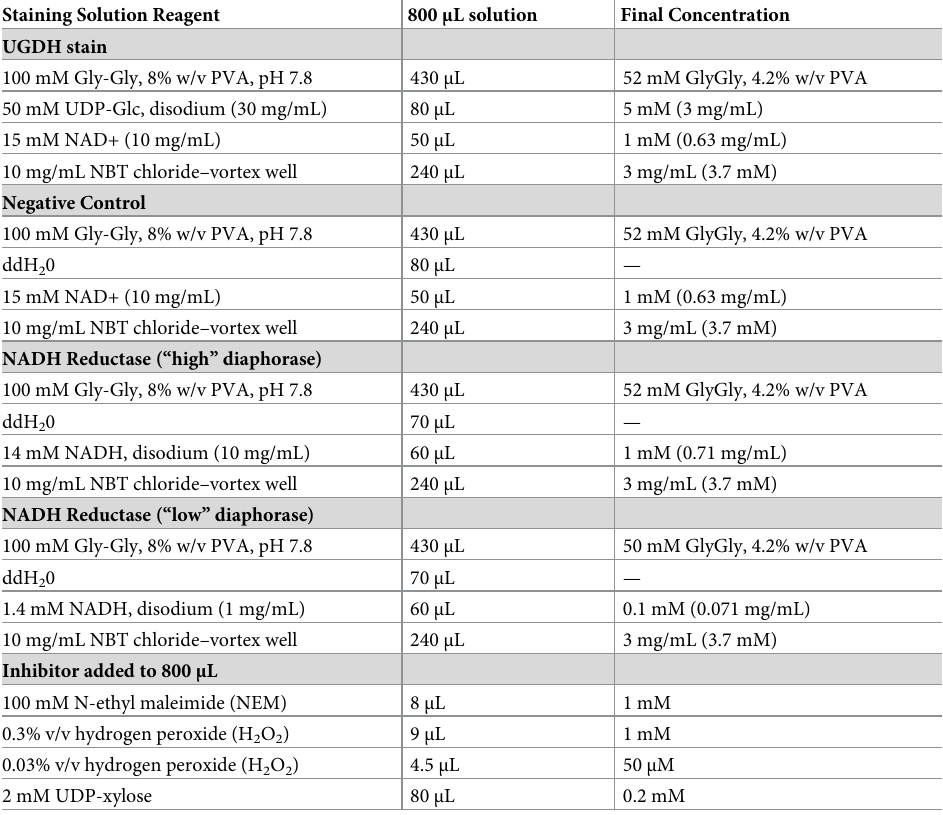
Table 2. In situ enzyme staining reaction conditions. Staining Solution